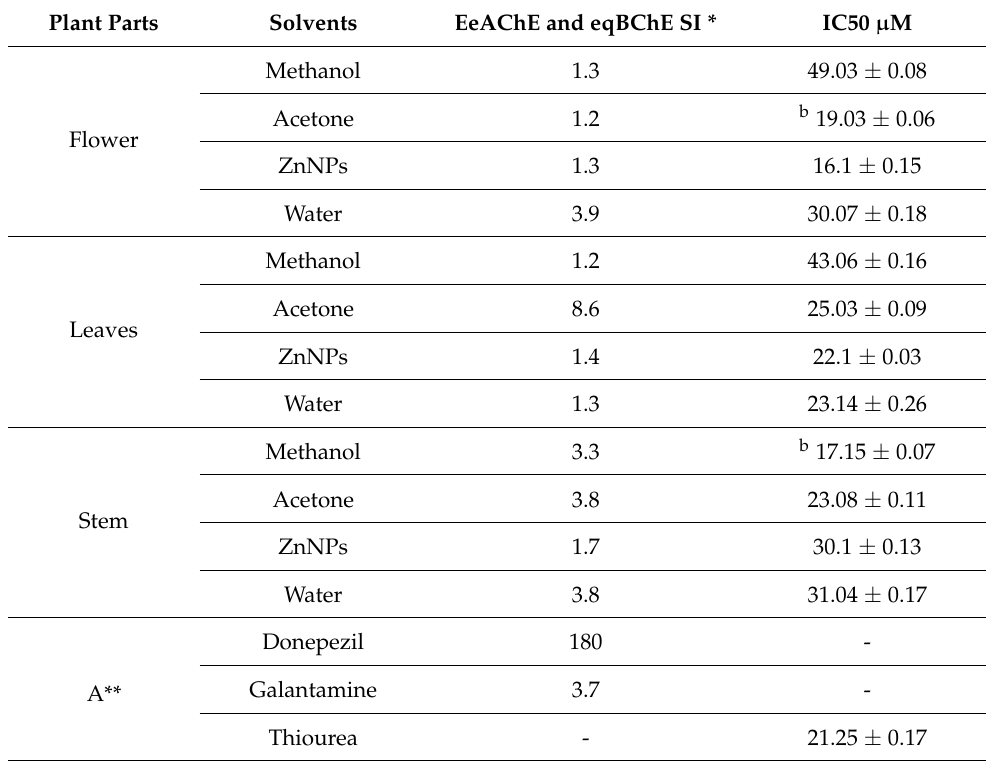
Table 1. AChE , BChE and increase inhibitory activities IC 50 ( µ M ± SEM)A** of ( Calotropis gigantea ) extracts and